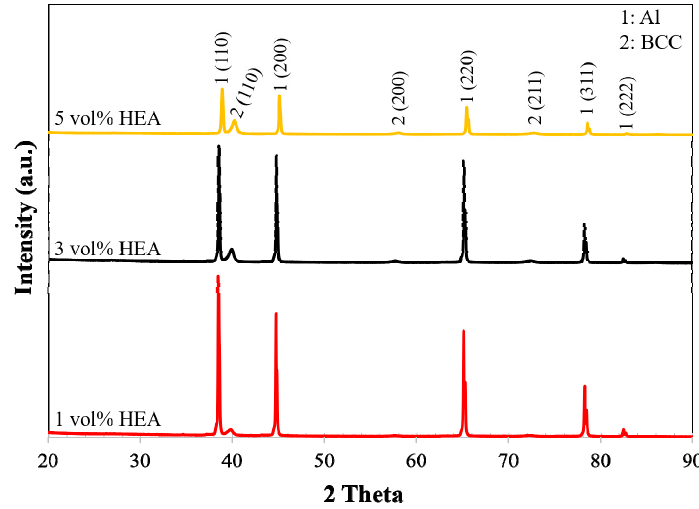
Figure 2. X ‐ ray diffractograms of Al ‐ HEA composites. Figure 2. X-ray diffractograms of Al-HEA composites.